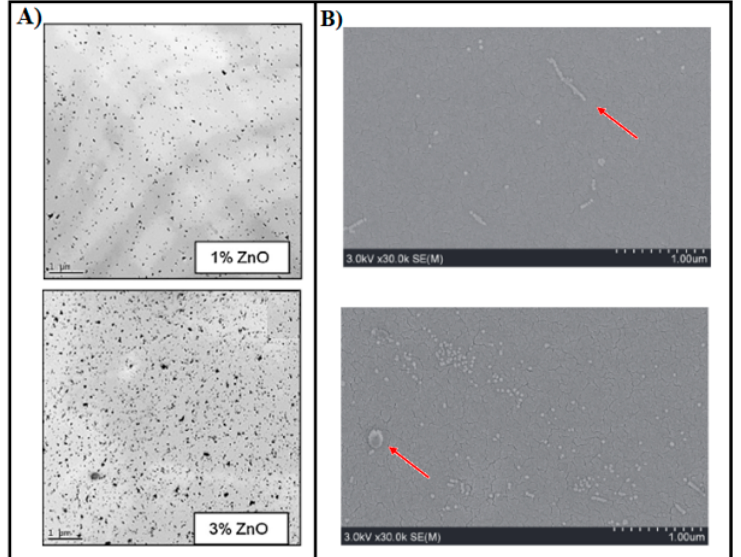
Figure 15. ( A ) TEM images of surface coated PLA nanocomposites filled with 1 and 3 wt% of ZnO nanoparticles (even dispersion), adapted from [262] with permission from Elsevier. Copyright© 2013. ( B ) SEM images of PLA nanocomposites containing 1–1.5 wt% of ZnO without any surface treatment (particle agglomeration indicated by red arrows), adapted from [158] with permission of Elsevier. Copyright © 2018.